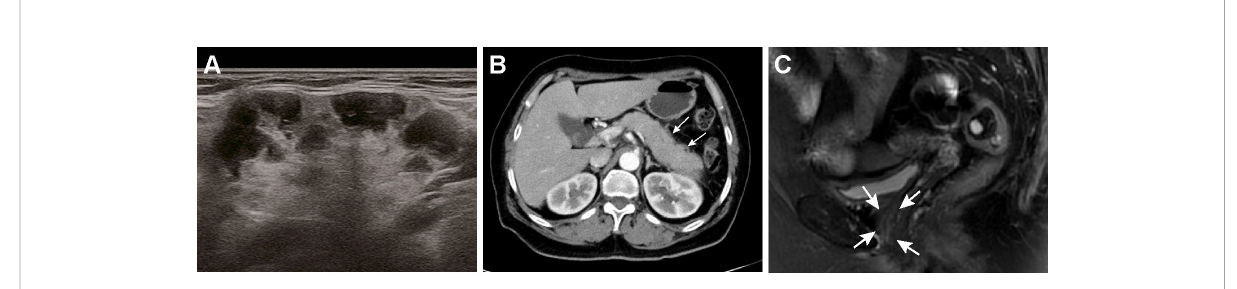
FIGURE 3 Radiological manifestations of the salivary glands and pancreas and signi fi cant improvement of periurethral mass after treatment. (A) An ultrasound image of the right submandibular gland showing numerous patchy hypoechoic regions inside the glandular parenchyma. (B) Contrast-enhanced CT scan of the abdomen showed the pancreas appears diffusely enlarged with a hypodense peripancreatic rim (white arrows). (C) After 3 months of treatment, MRI of the pelvis revealed marked decrease in size of the periurethral mass (white